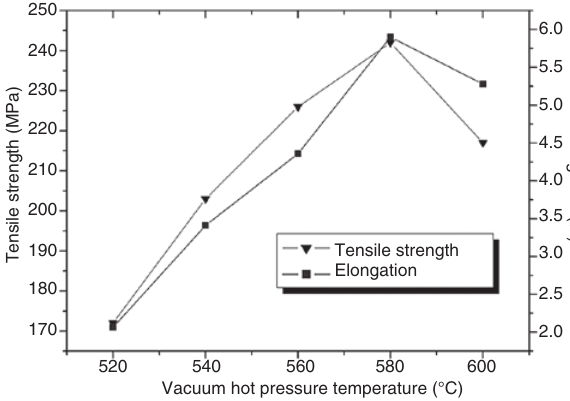
Figure 10 The tensile strength and elongation as a function of the T6 heat treatment for the composite under different sintering